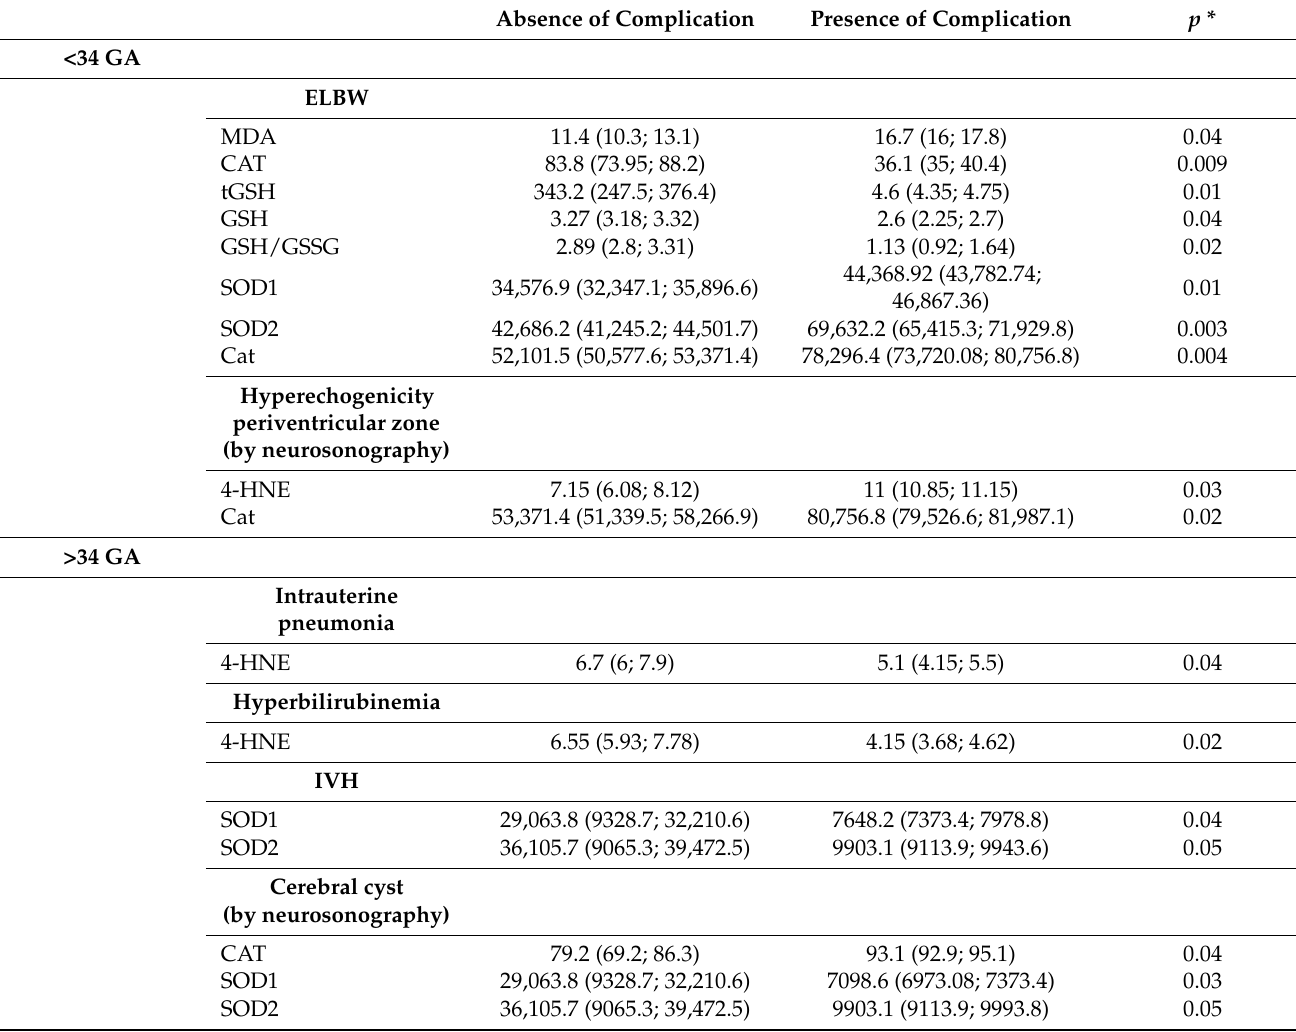
Table 3. Evaluation of pro- and anti-oxidant markers’ expression depending on the presence or absence of perinatal and neonatal complications in newborns with FGR. Absence of Complication Presence of